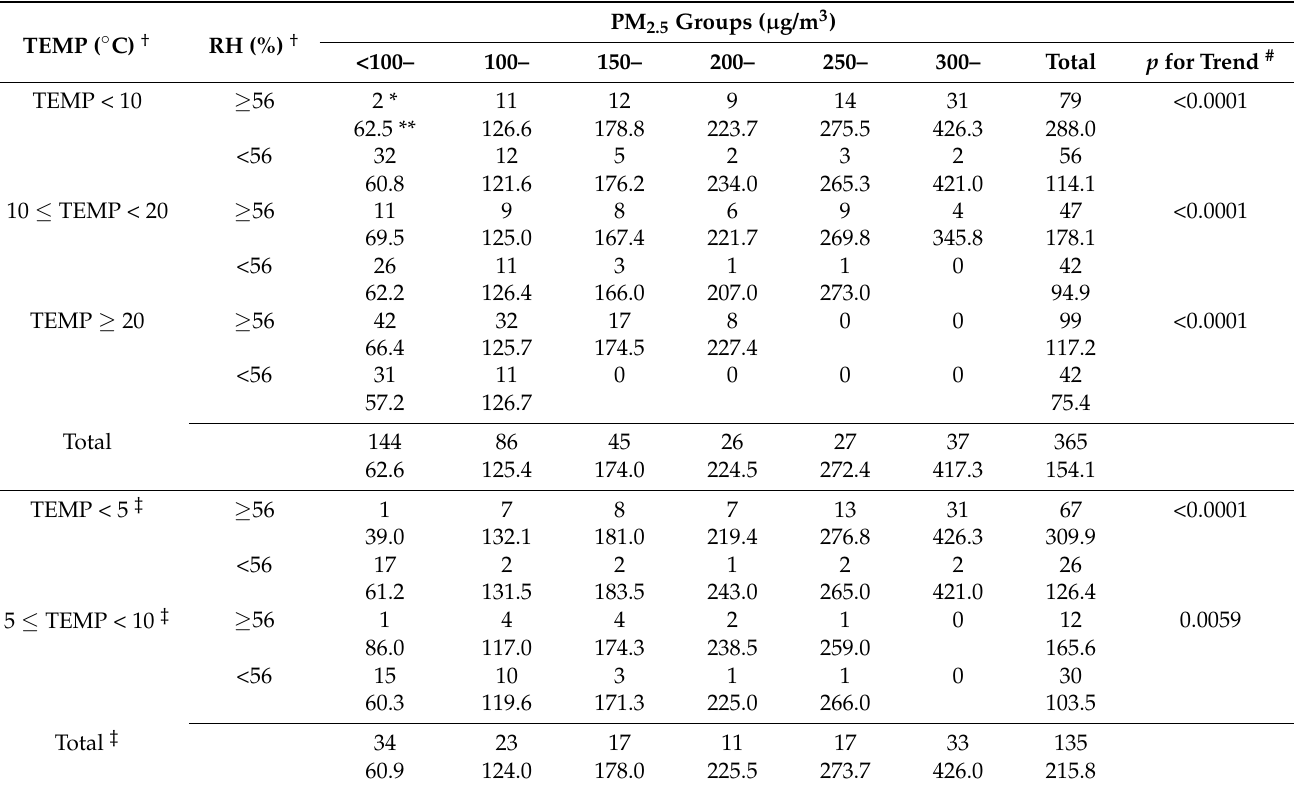
Table 2. PM 2.5 relation to air temperature and relative humidity in y city in